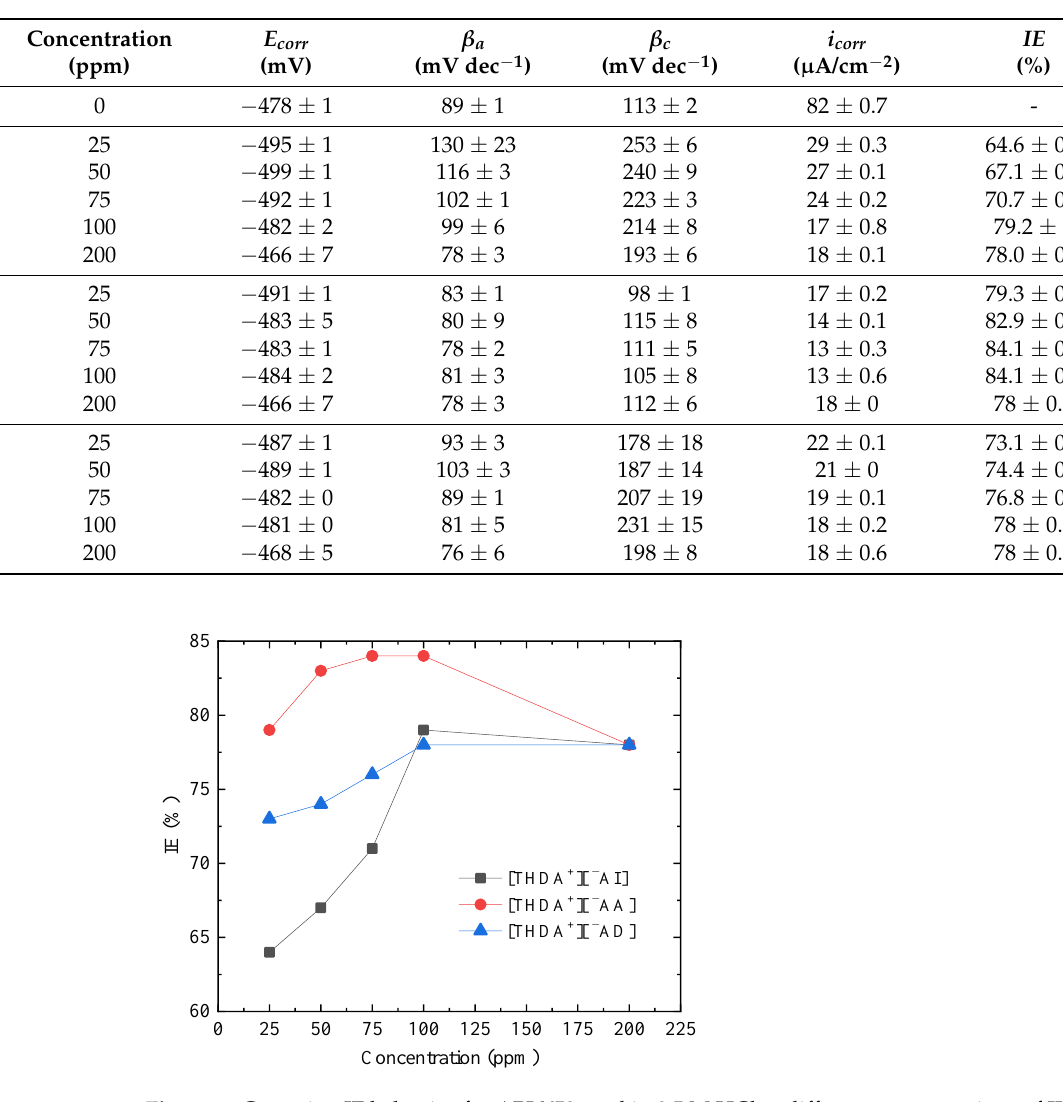
Table 3. Electrochemical data for [THDA + ] and the anions [ − AI], [ − AA], and [ − AD] at different concentrations.